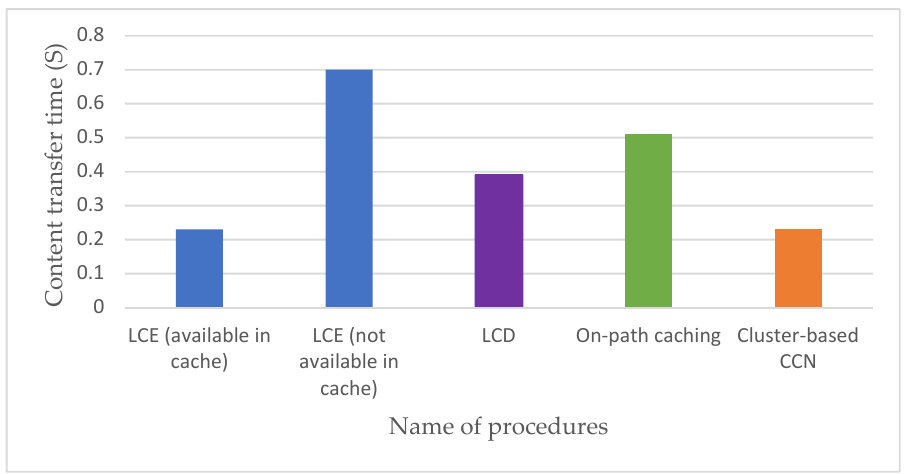
Figure 9. Comparison among proposed and state-of-the-art caching mechanisms.